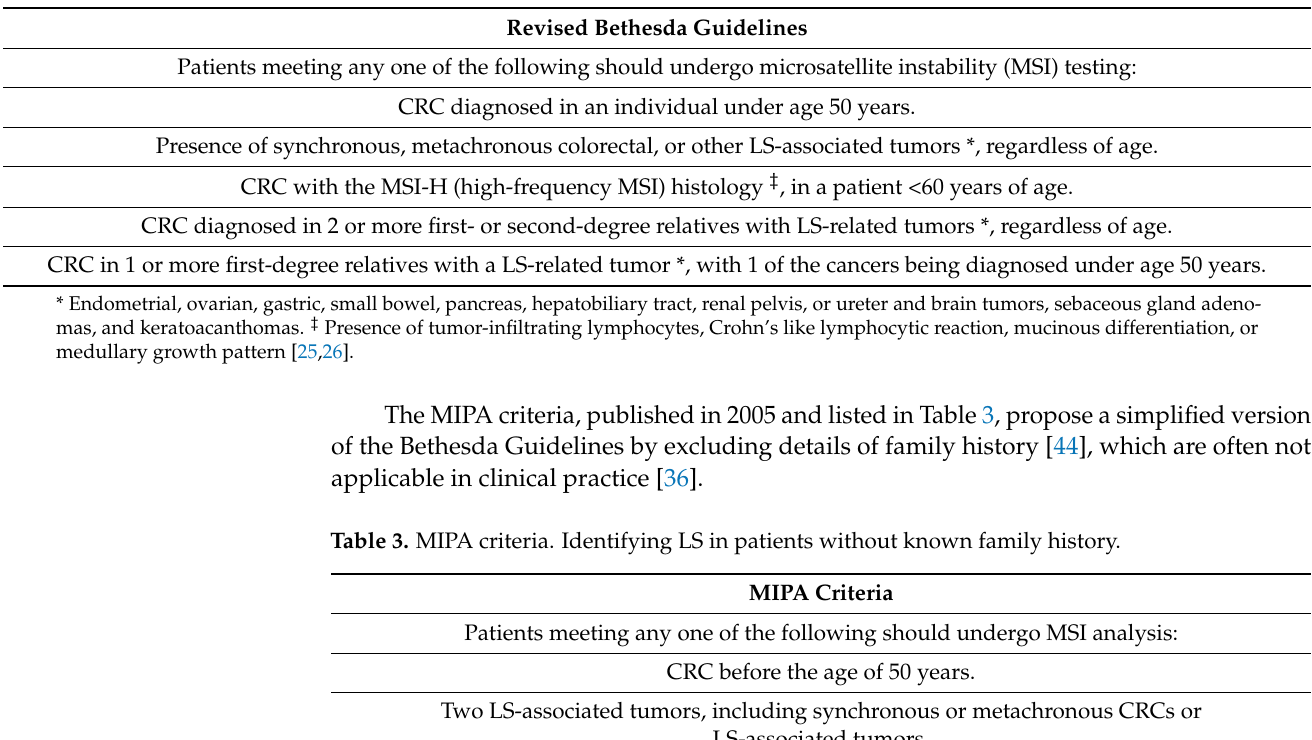
Table 2. Bethesda Guidelines as current recommendation for LS identification.